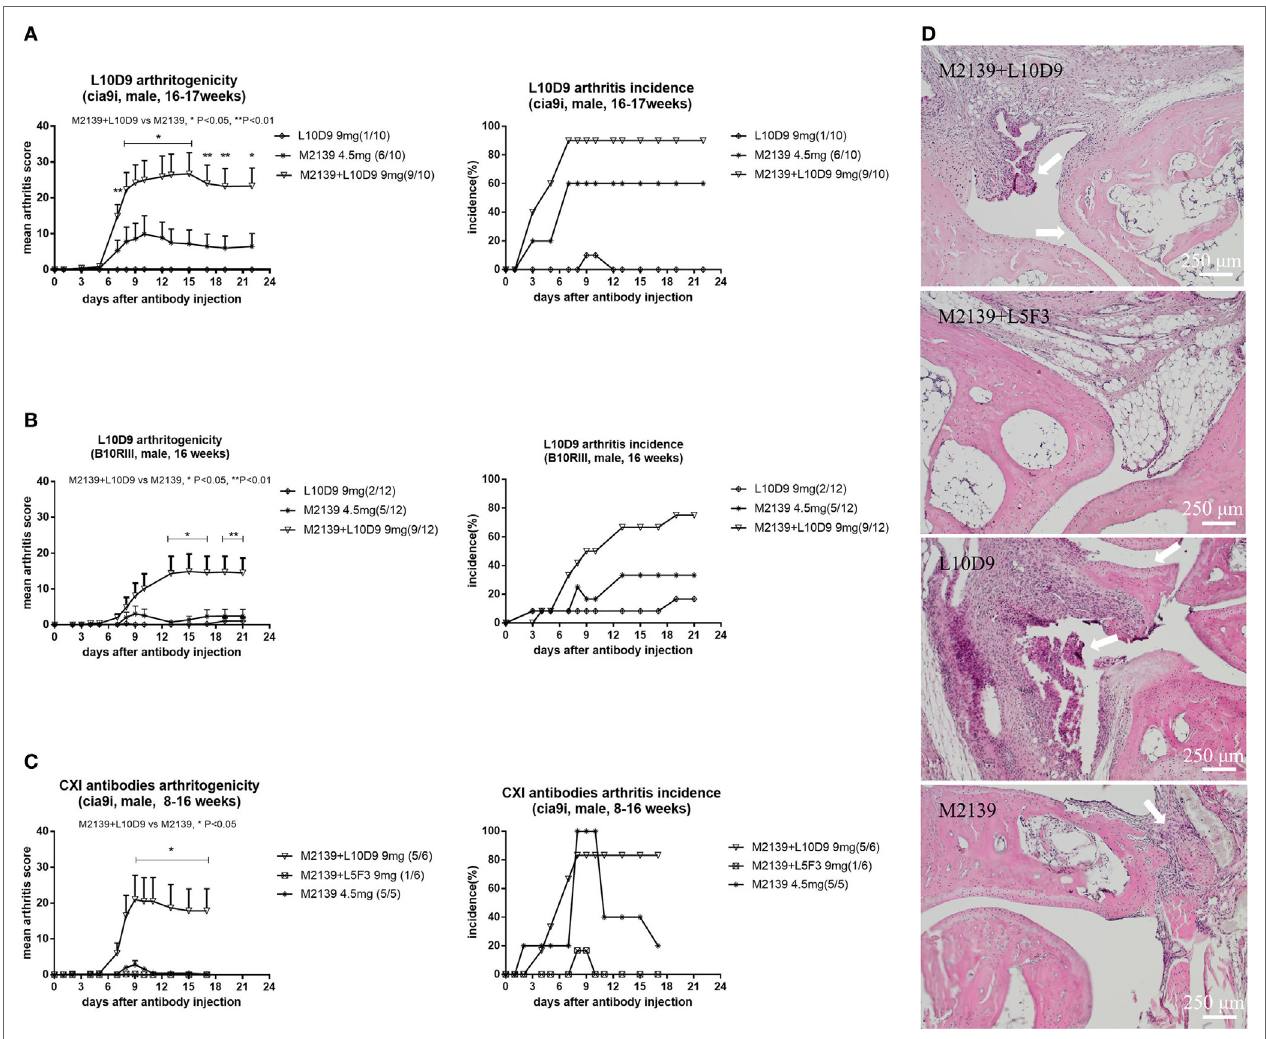
FigUre 5 | L10D9 mediates arthritis in mice. Mean arthritis score and arthritis incidence in B10RIII strain (B) and BQ.Cia9i strain (a,c) are indicated. (D) Histology of joint sections. Results shown are representative pictures of each group. Infiltrating cells, glycosaminoglycan loss, and joint surface erosions are indicated with arrows. Statistics were determined by the Mann–Whitney U -test for daily mean arthritis score and Fisher’s exact test for the disease incidence between